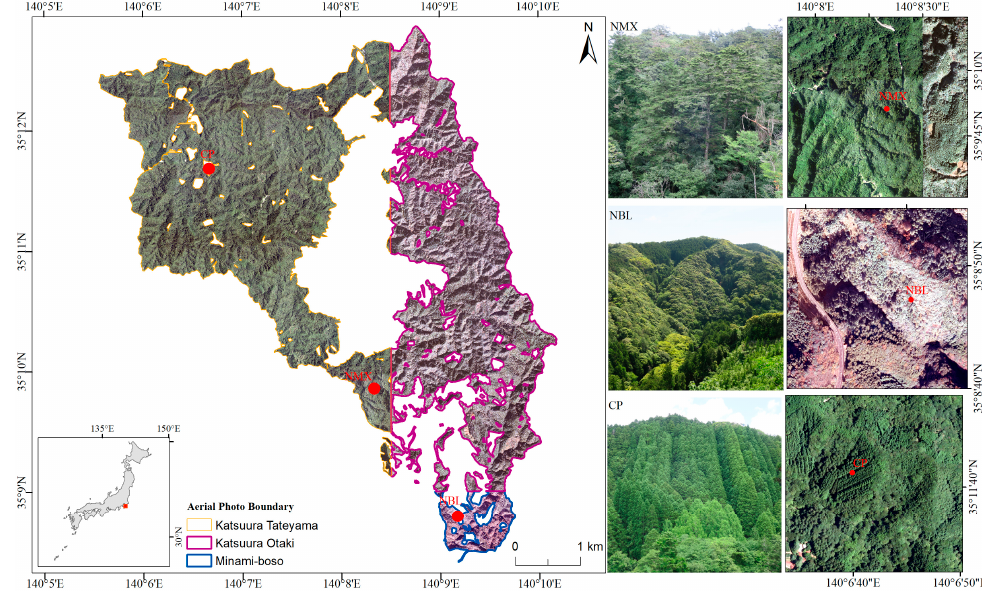
Figure 1. Location of the study area and views of typical forest sites. NMX, NBL, and CP indicate natural mixed forest, natural broadleaved forest, and conifer plantation, respectively. The aerial photographs form three datasets collected at different times in the Katsuura Tateyama, Katsuura Otaki, and Minami Boso districts. The aerial photographs were taken by Geospatial Information Authority of